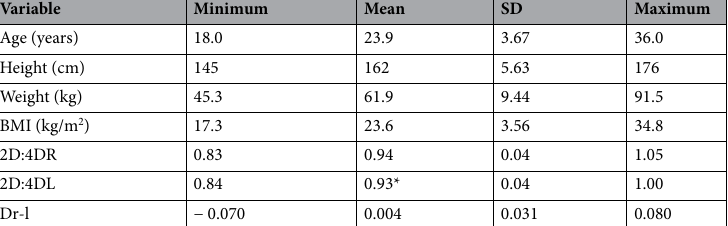
Table 2. Sociodemographic (continuous) and anthropometric variables of the mothers involved in the study. Results of socio-demographic characteristics (continuous) and anthropometric variables of the 272 mothers presented as minimum, mean, standard deviation (SD) and maximum values for each variable. *Significant at P = 0.020 when compared to the 2D:4DR (paired t -test, 2-tailed).